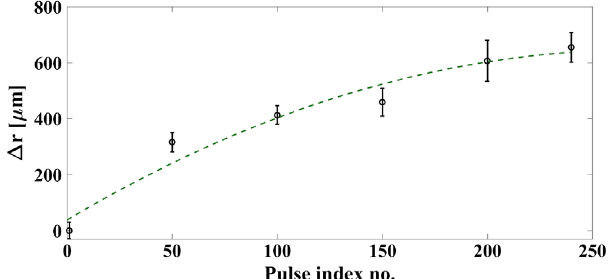
FIG. 12. Schematics of bunch train operation within rf macro- pulse with illustrative correlations with time, gun temperature change, and frequency detuning.